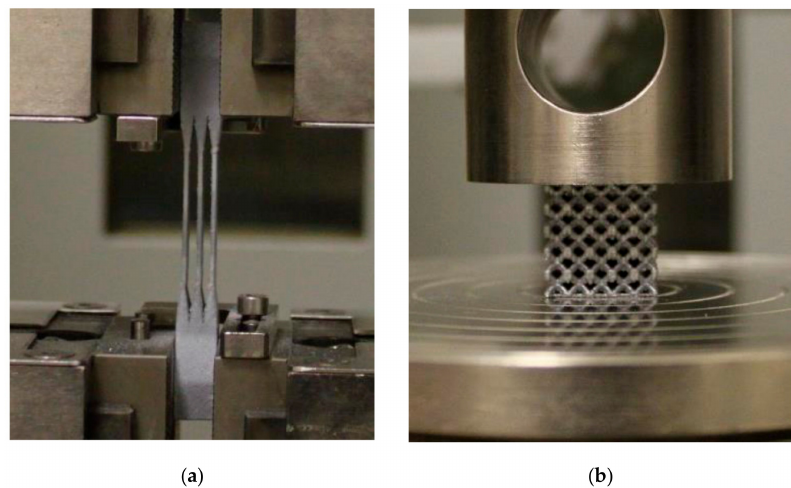
Figure 5. Mechanical testing using Zwick Z020 machine ( a ) tensile test; and ( b ) compression